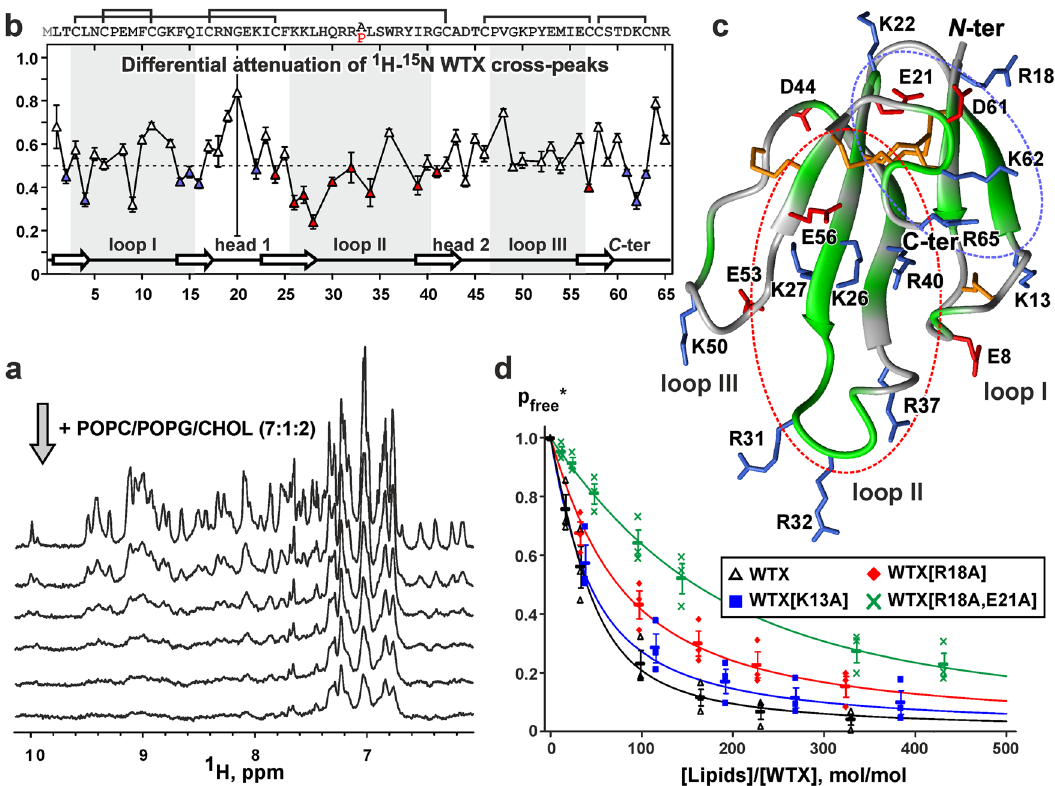
Fig. 3 Interaction of WTX and its mutants with lipid vesicles. a Amide-aromatic regions of 1D NMR spectra of WTX measured at different vesicle concentrations. The drop in intensity of NMR signals corresponds to binding of the toxin to the vesicles and decrease in the apparent fraction of the free toxin in solution ( P free *). b Relative attenuation of intensities of backbone NH cross-peaks in the 15 N-HSQC spectrum of WTX induced by addition of POPC/POPG/CHOL vesicles. Data are values obtained from a single NMR experiment. Error bars are experimental errors. The 0.5 threshold line subdivides the data in two groups: the residues interacting with the vesicles or not. Color code corresponds to the regions highlighted by ellipses on c . c Spatial structure of WTX[P33A] mutant (used for the model building, see Methods) in ribbon representation. Disul fi de bonds, positively charged, and negatively charged residues are colored in orange, blue, and red, respectively. The protein ribbon is colored according to vesicle-binding data from b . The residues interacting with the membrane are in green. Two protein regions responsible for protein-membrane interaction are shown by dashed ellipses. d Binding isotherms for WTX and its mutants are approximated by the Langmuir equation. Fitted parameters are summarized in Supplementary Table 3. The P free values shown are the mean ± S.E.M. of three independent titration experiments ( n = 3). * p < 0.05 and *** p < 0.001 indicate the signi fi cant difference between groups by Repeated-Measures one-way ANOVA/Tukey ’ s test. Please note that obtained isotherms represent upper approximation to the real binding parameters. In the presence of slow-intermediate (on NMR timescale) exchange between the free toxin in solution and membrane bound toxin, the apparent P free * value calculated from the NMR signals intensity is always lower than true P free